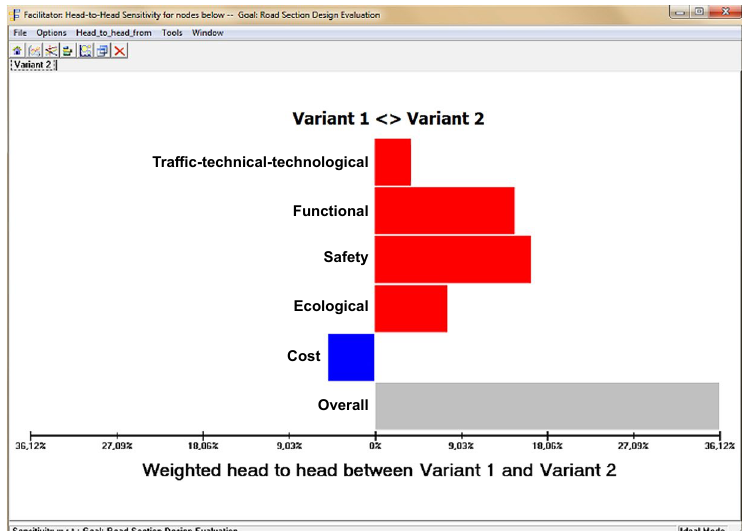
Fig. 5. Priority of alternatives for different criteria depicted using a head-to-head graph